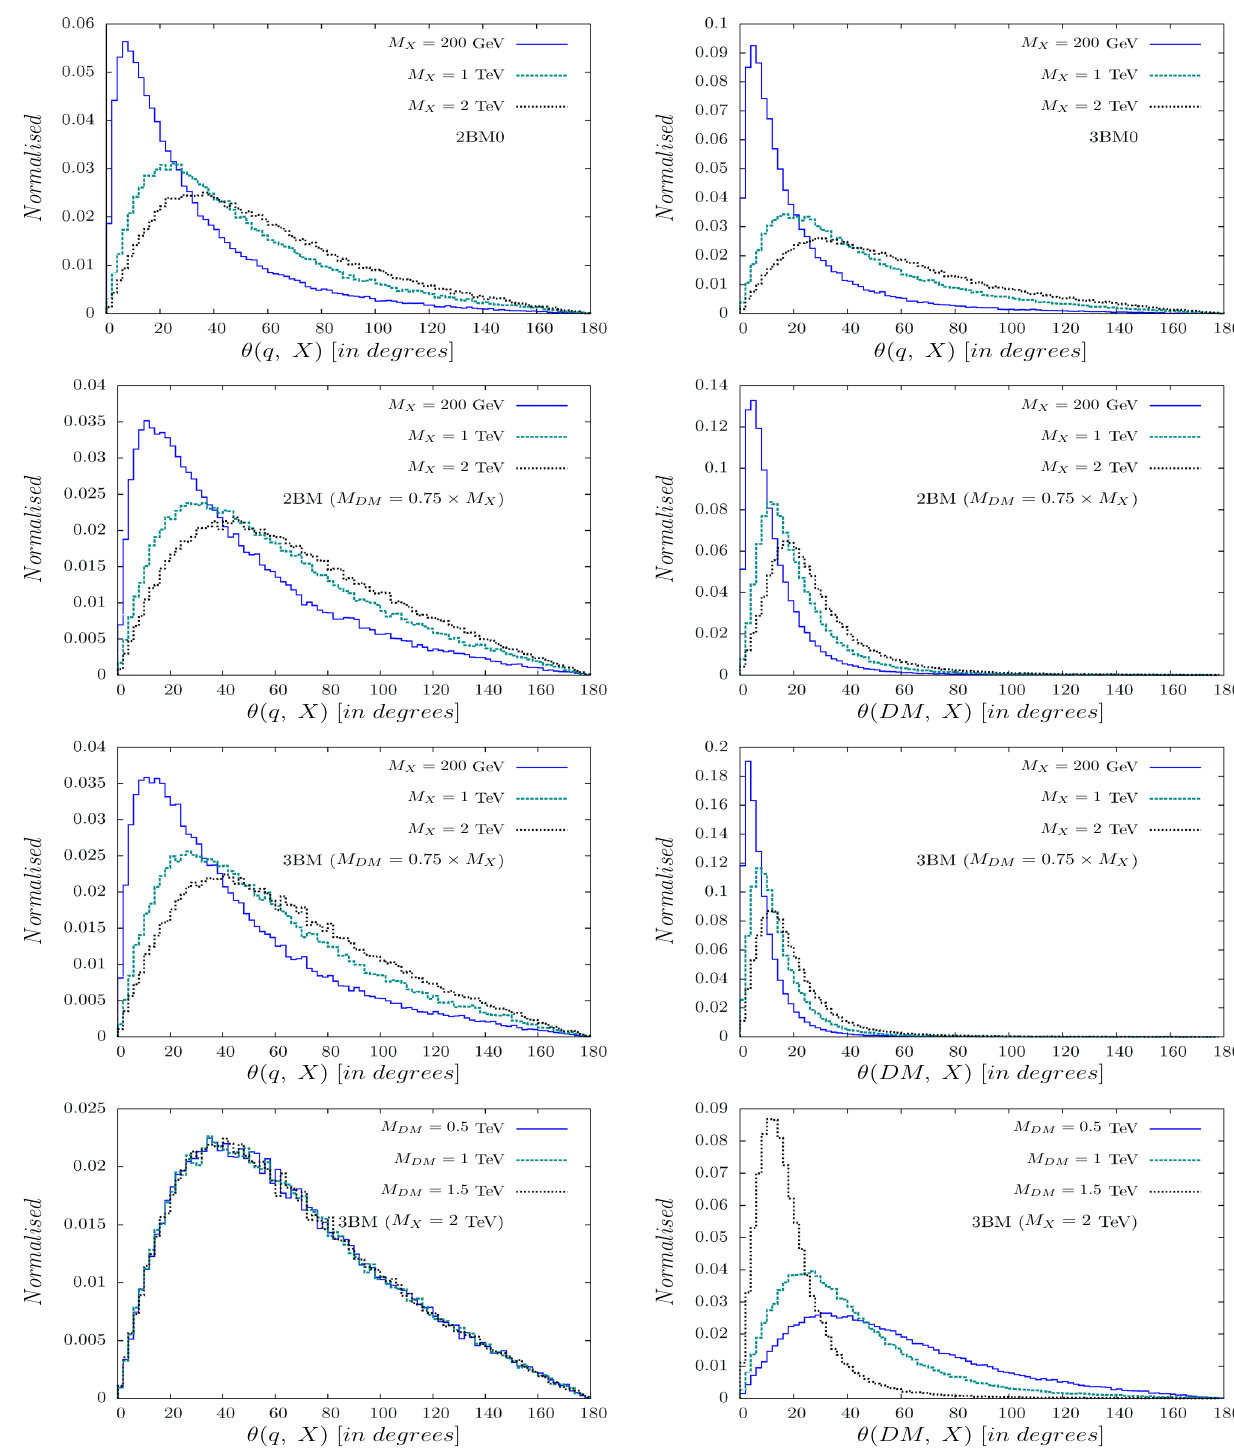
Fig. 13 Angle θ between the direction of X and one of the quarks, q or the massive daughter (DM)